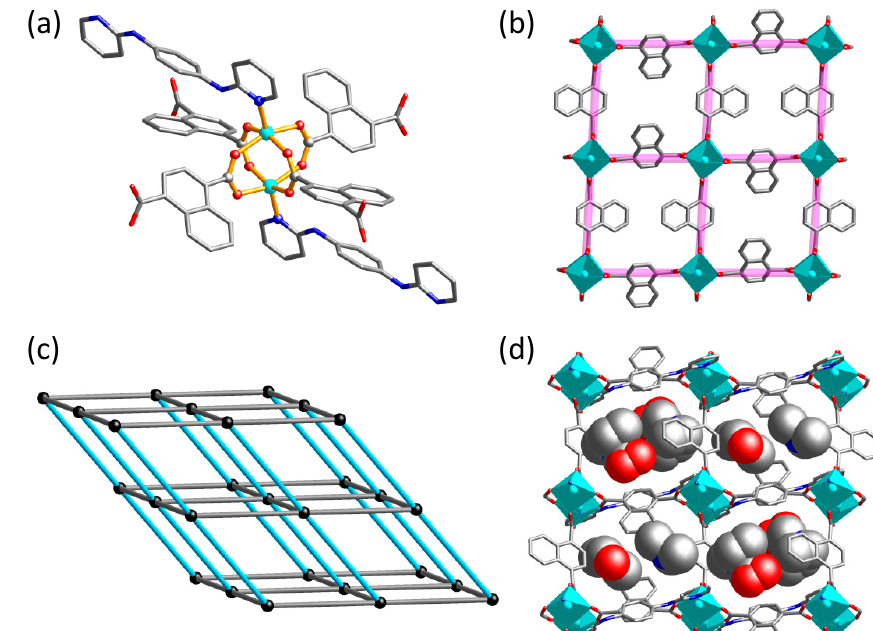
Figure 3. Molecular structure of 4 : ( a ) Coordination environment around Zn(II) center; ( b ) a single 2D Zn − 1,4 ‐ ndc 4 4 ‐ sql layer; ( c ) schematic representation of the whole 6 ‐ connected distorted pcu ‐ type pillared ‐ layer framework; ( d ) packing diagram viewed down the crystallographic a ‐ axis, showing lattice DMF molecules inside the solvent accessible pores.